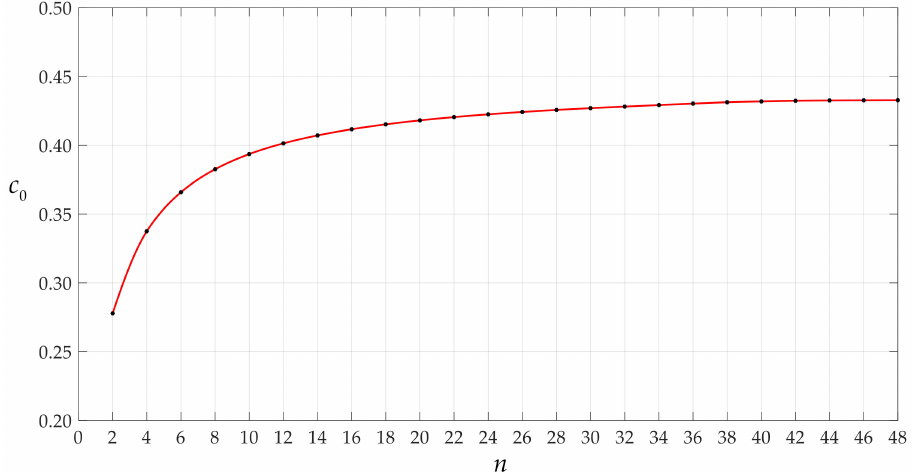
Figure 11. Variations of c 0 with n when q takes 0.0105 MPa.